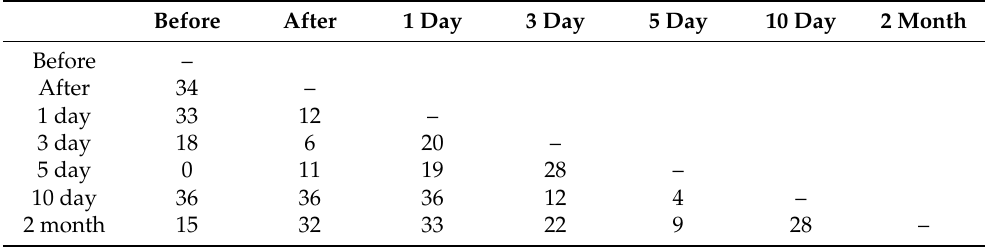
Table 1. Wilcoxon test values based on clinical trial data. The data for each day corresponds to the average saturation value for all patients participating in the selected